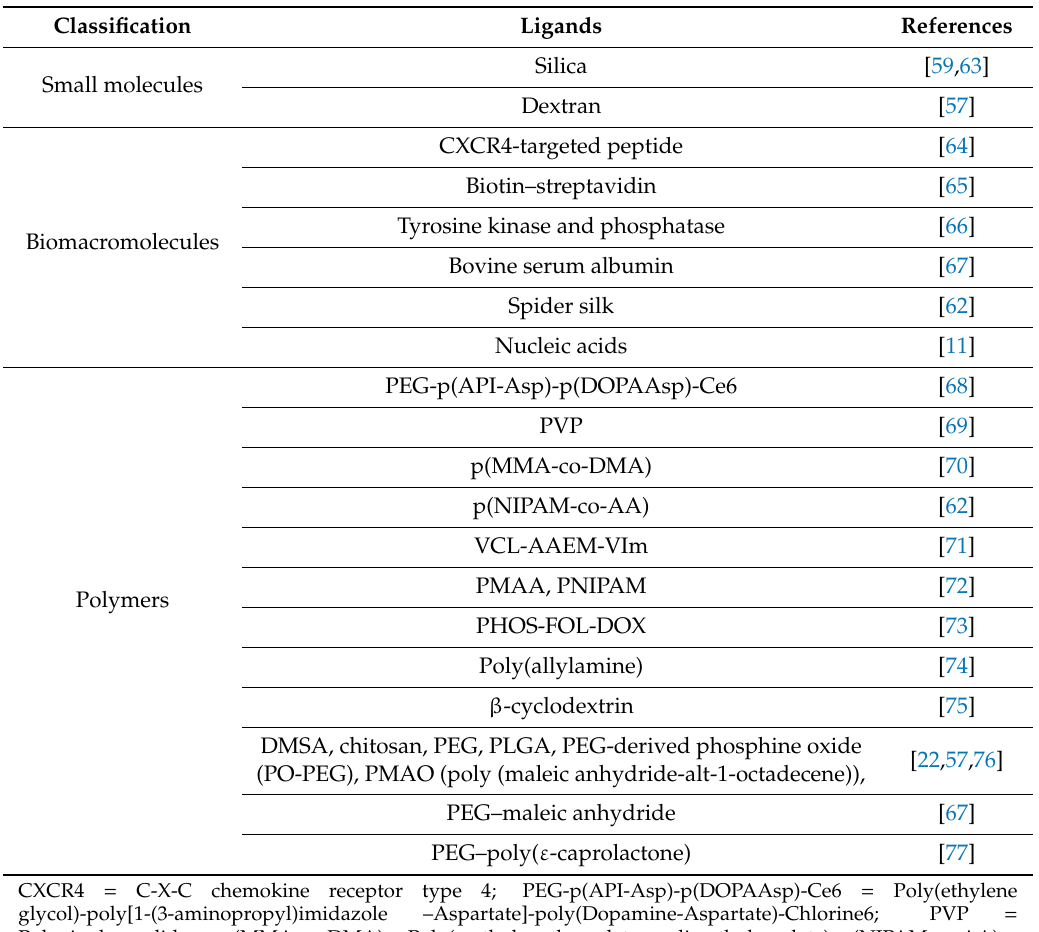
Table 2. Examples of biomacromolecules and polymers used as ligands for assembly of iron-oxide magnetic nanoparticles